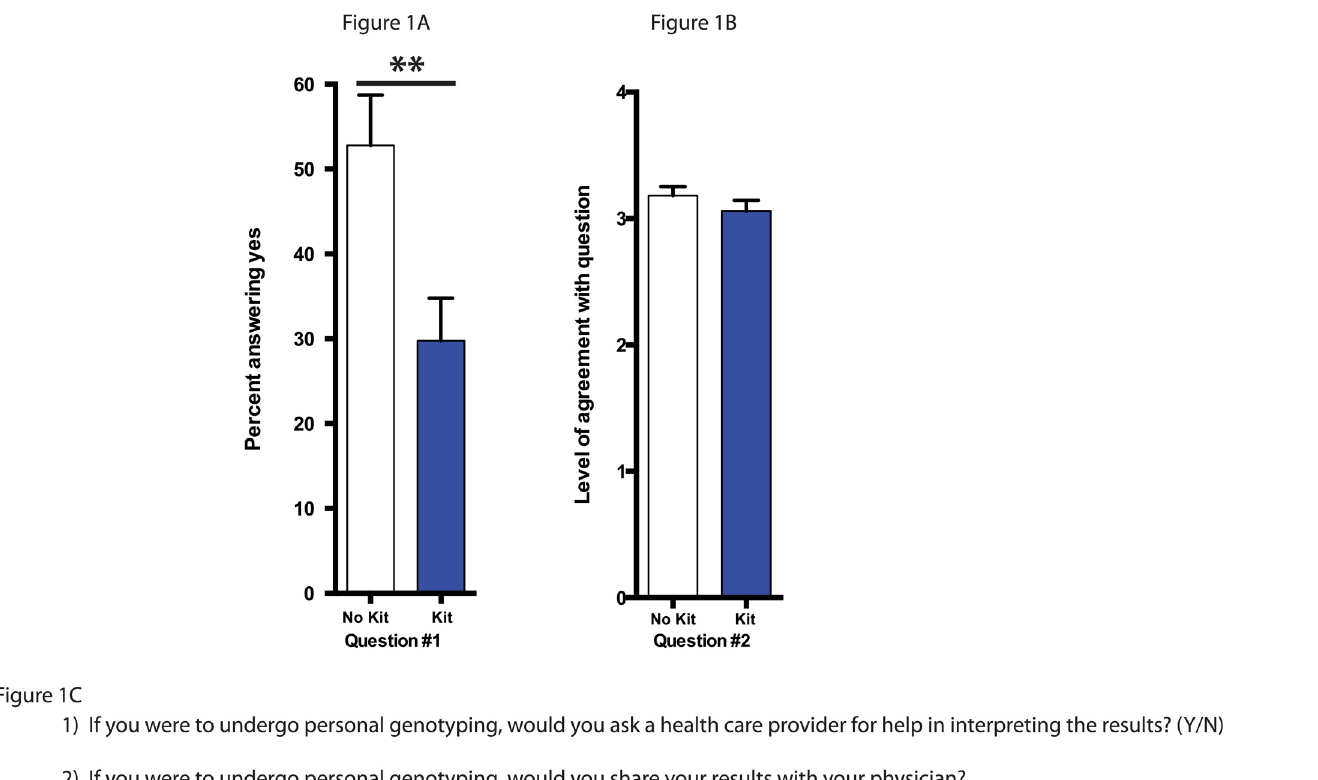
Fig 1. Student attitudes about sharing personal genomics data. A) Percentage of students answering “ yes ” to question #1 about whether they would ask health care workers for help in interpreting their results. B) Student responses to Question #2 regarding whether they would share their results with a physician. For A and B, statistical analysis performed using an unpaired Student t-test and all values are mean ± SEM with n = 71 for no kit (white), and n = 84 for kit (blue) ( ** = p < .01). C) Student survey questions 1 – 2.